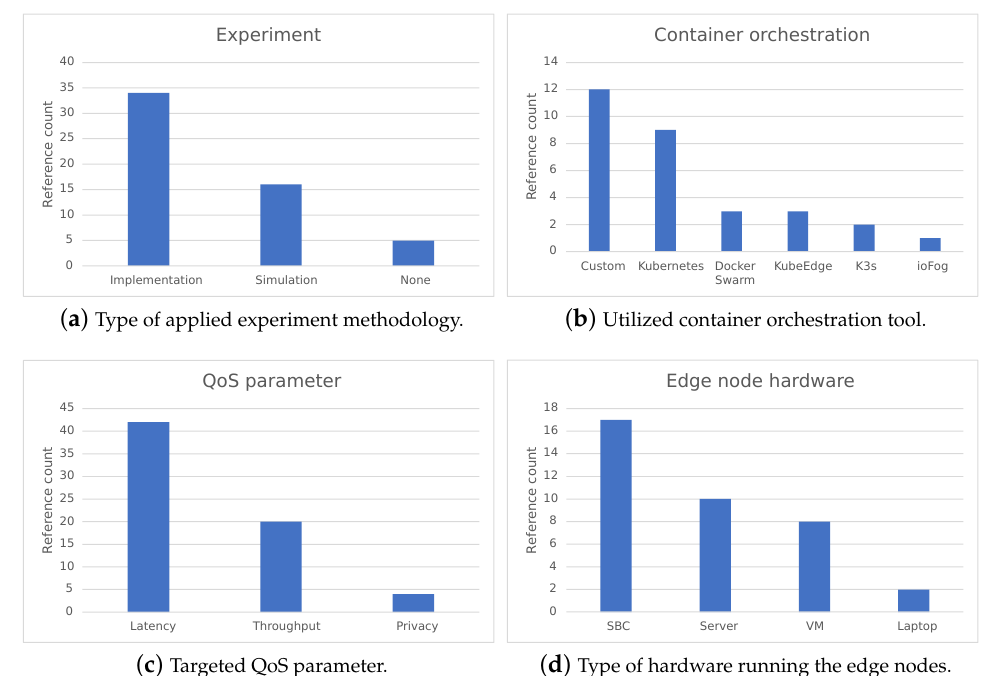
Figure 2. Summary of a related work survey (distribution by